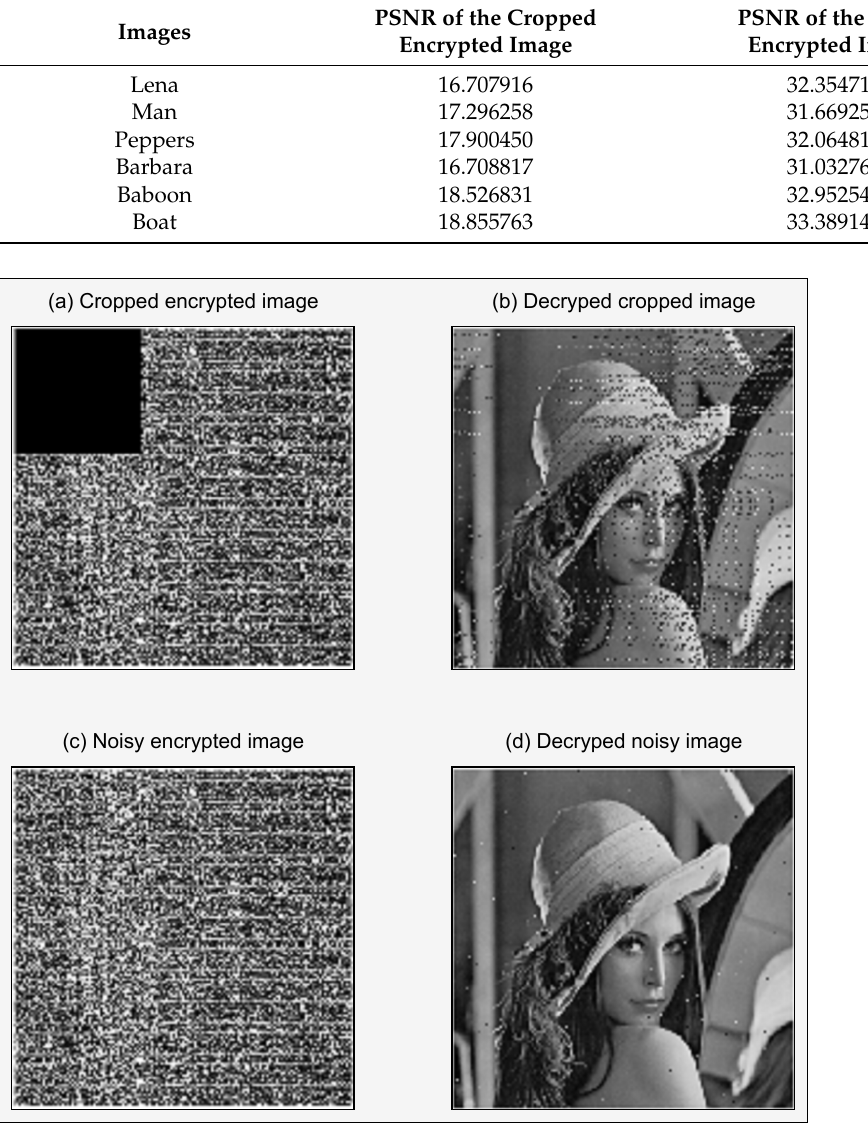
Figure 11. Results of encrypted and decrypted Lena image with cropping and noise